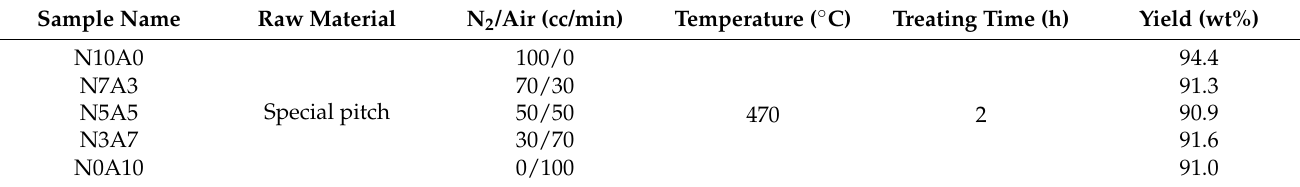
Table 2. Change in binderless coke yield according to flow ratio of nitrogen and air.